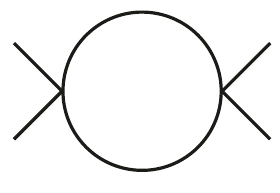
Figure 3 . Bubble